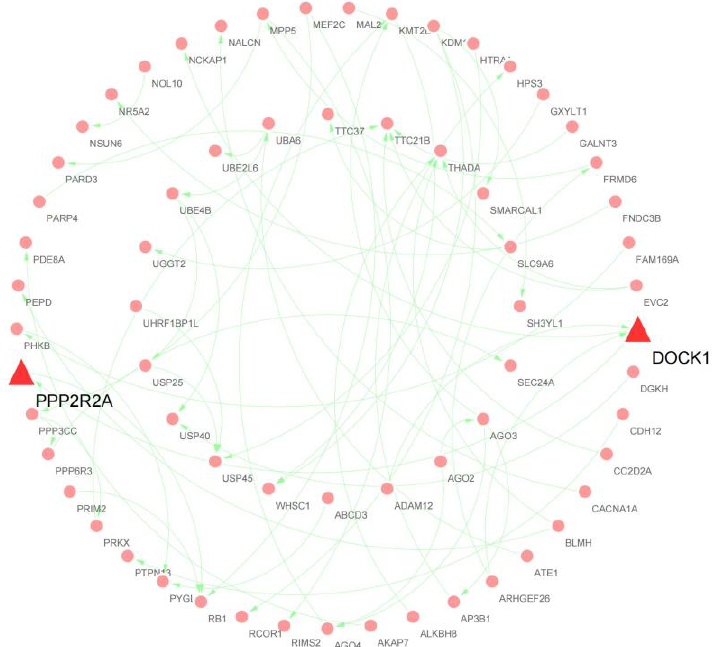
Figure 4. Analysis of the DEcircRNA host gene PPI network. The red and pink colors represent the identified host genes participating in the network; the central host genes are indicated by red triangles.